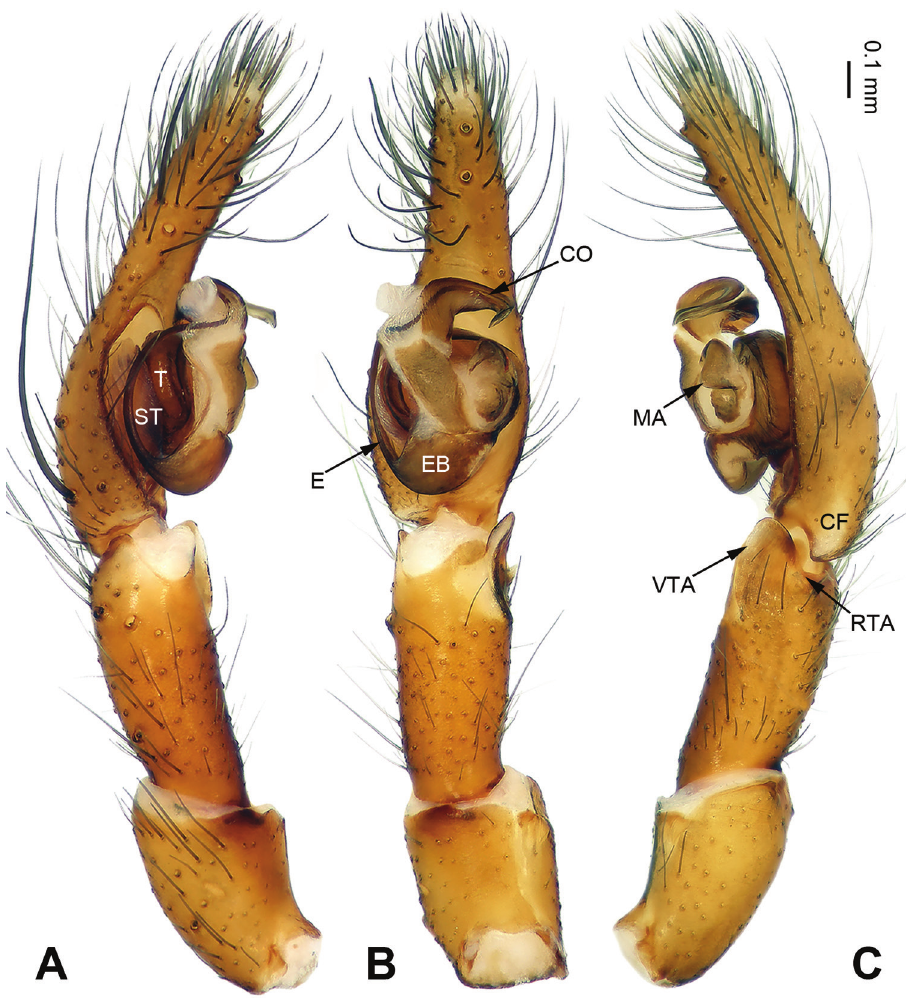
Figure 6. Male palp of Pireneitega kovblyuki sp. n., holotype. A Prolateral B Ventral C Retrolateral. Scale bar 0.1